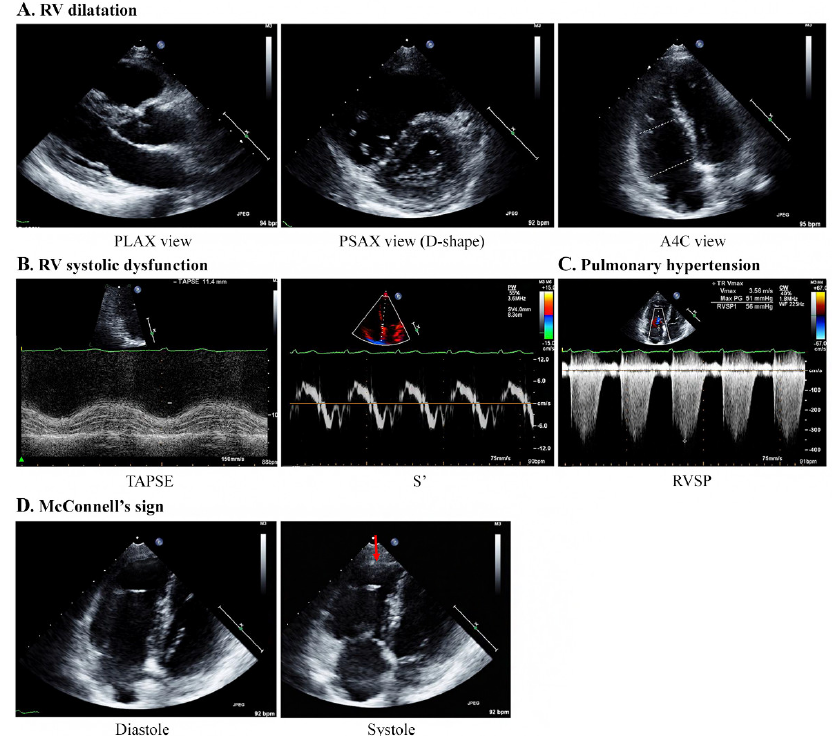
Figure 3. Specific echocardiography features concerning patients with PTTM. A 40-year-old woman with breast cancer (Case 1). ( A ) Echocardiography results indicate RV dilatation with a D-shaped LV (mid/basal RV size: 29/40 mm). ( B ) TAPSE and S’ are 11.4 mm and 7.4 cm/s, respectively, indicating a decrease in RV systolic function. ( C ) The TR Vmax is 3.56 m/s, indicating PH. ( D ) McConnell’s sign, which is an akinesia of the RV mid-free wall except for the apex (red arrow), is observed. Abbreviations: A4C, apical 4 chamber; PLAX, parasternal long axis; PSAX, parasternal short-axis view; PTTM, pulmonary tumor thrombotic microangiopathy; RV, right ventricle; RVSP, right ventricular systolic pressure; S’, lateral tricuspid annulus peak systolic velocity on tissue Doppler imaging; TAPSE, tricuspid annular plane systolic excursion; TR V max, tricuspid regurgitation maximum velocity.